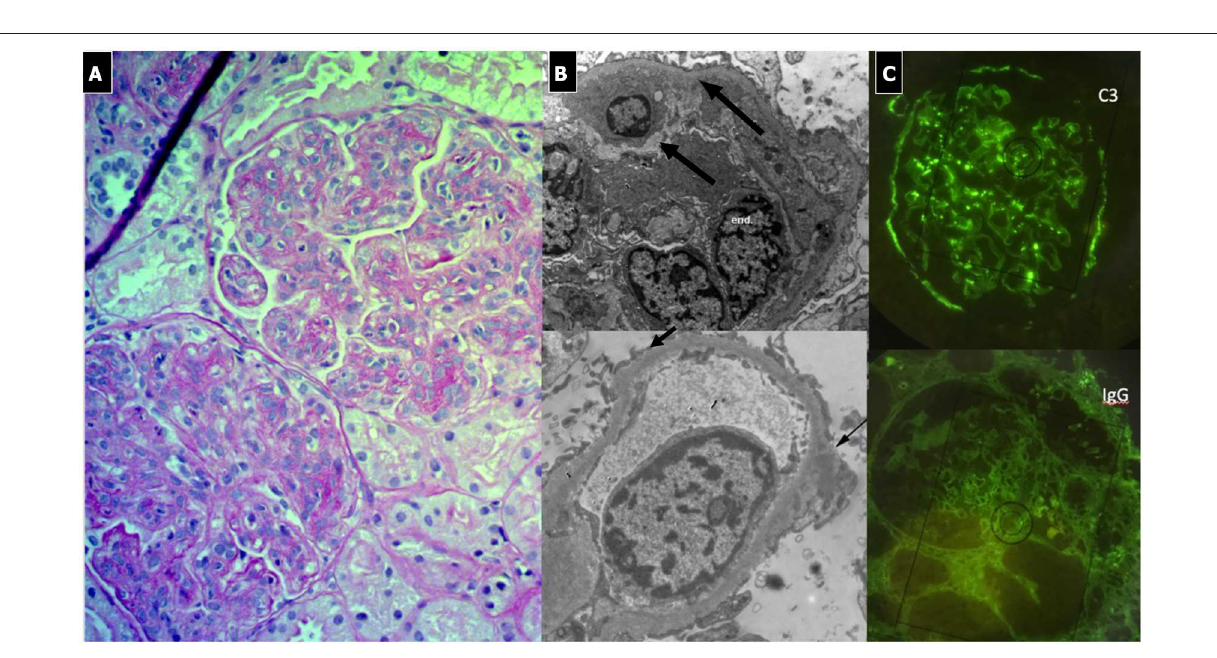
FIGURE 5 | C3 Glomerulonephritis. (A) LM (PAS stain) shows lobular pattern with evidence of diffuse endothelium-mesangial proliferative GN. (B) EM demonstrates the splitting of GMB due to mesangial interposition (arrows). The lower image shows the presence of low intensity electron-dense sub-epithelial deposits (arrow). (C) IF shows the presence of C3 dominant